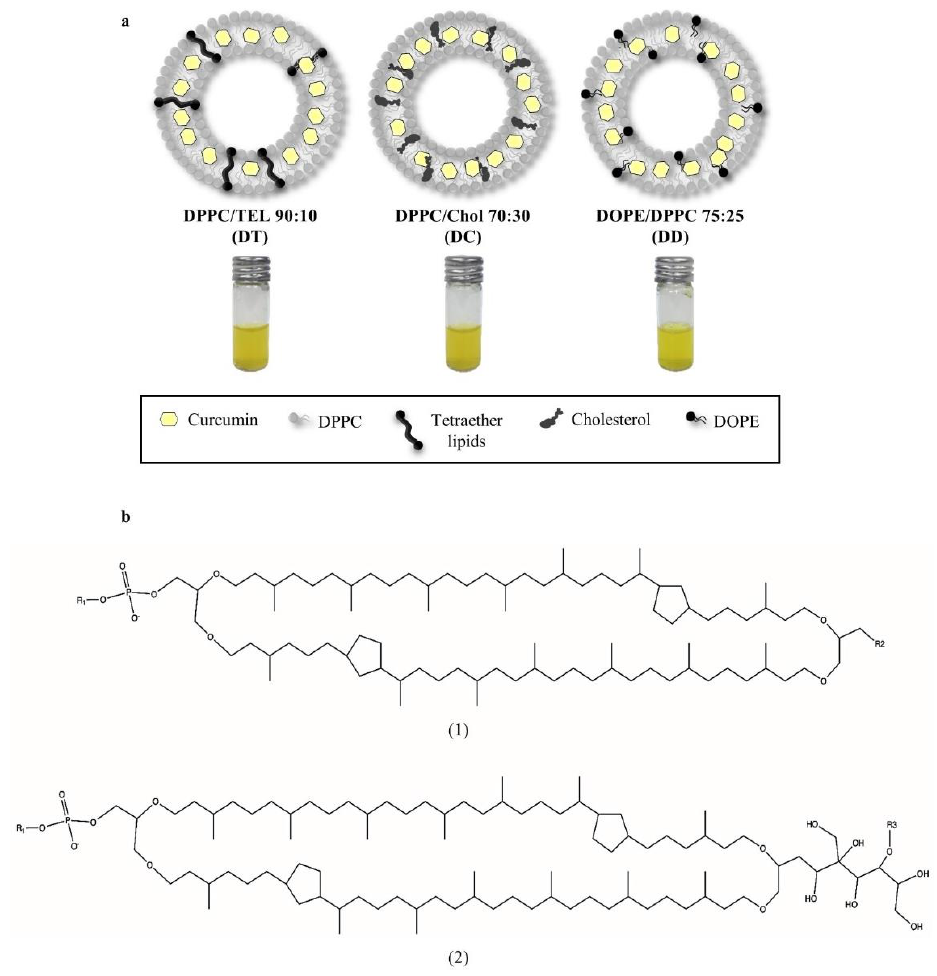
Figure 2. ( a ) Model compositions of liposomes: DT with tetraether lipids providing the highest degree of membrane stabilisation, DC as medium stabilised standard composition with cholesterol and the fluidic composition of DD with no stabilisation of the membrane. ( b ) Structures of the tet- raether lipids used in this study. ( 1 ) GDGT, glycerol dialkylglycerol tetraether and ( 2 ) GDNT, glyc- erol dialkylnonitol tetraether with R1: inositol, R2: β-D-glucopyranose and R3: β-D-galactosyl-β-D- glucopyranose.